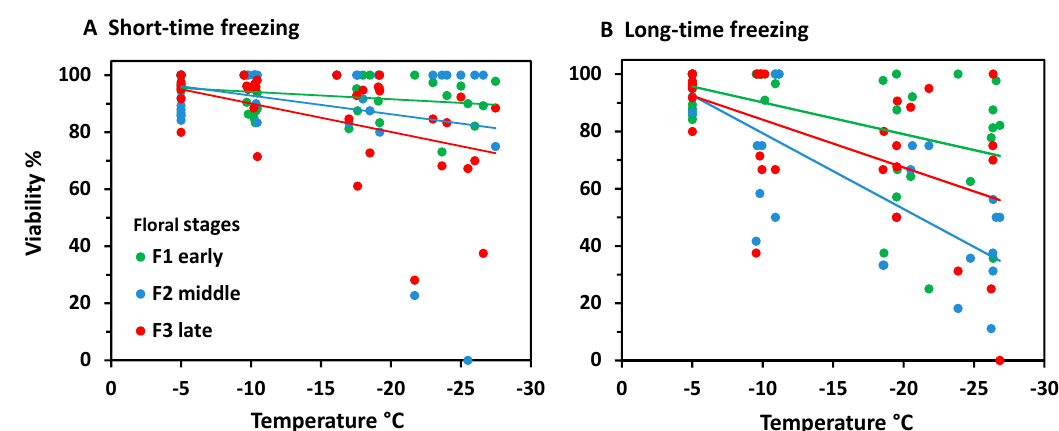
Figure 3. Saxifraga moschata Wulfen. Percent viability (TTC test) of floral winter buds in early (green), middle (blue) and late (red) developmental stages after ( A ) short-time and ( B ) long-time exposure at different freezing temperatures in experiment 2. For floral stages, see Figure 1. Each symbol refers to a single individual. Data at − 5 °C are control values of the respective stage. Trend lines indicate linear regressions.